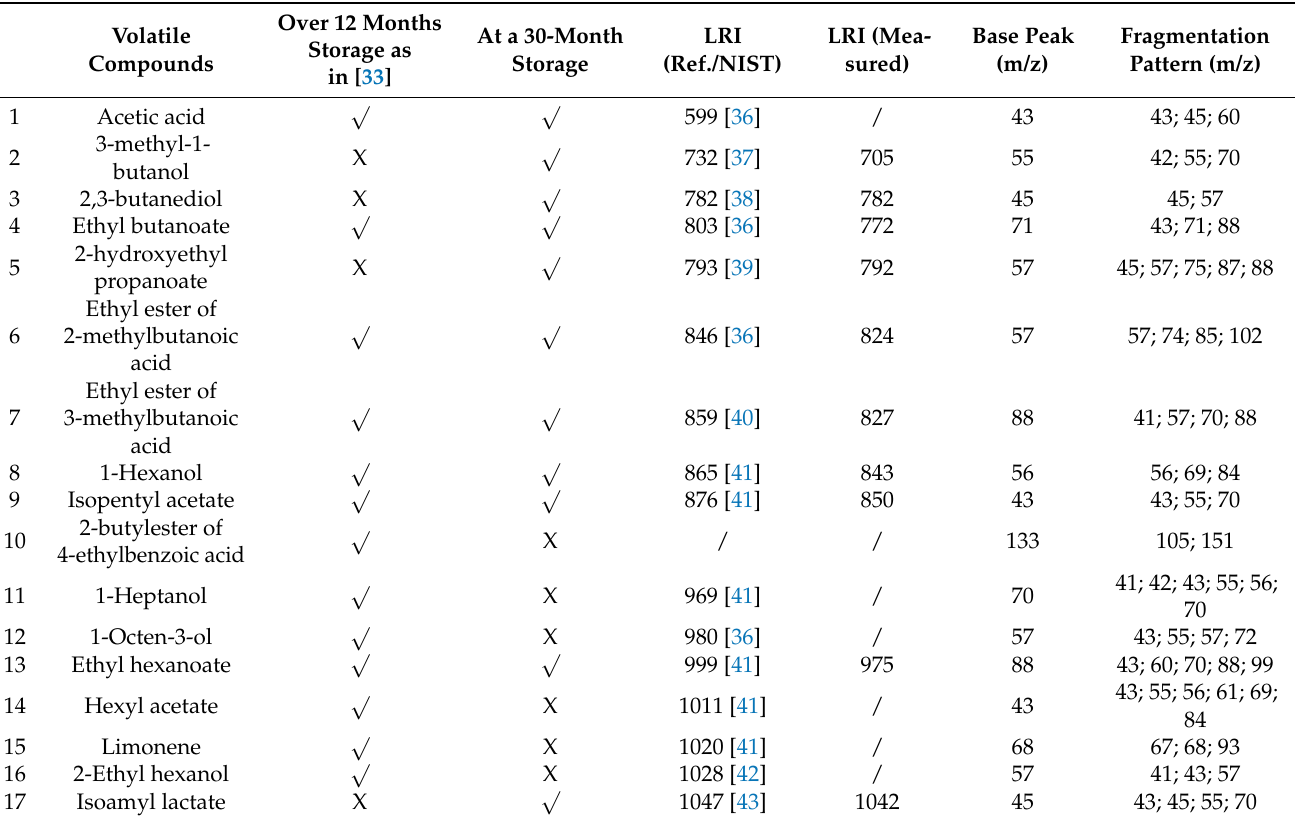
Table 2. Volatile compounds identified during 30 months of storage listed according to their elution order. LRI = Linear retention